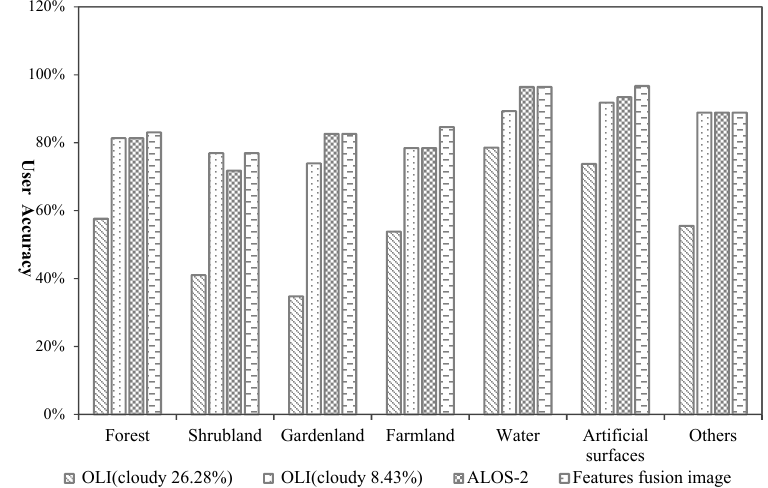
Figure 16. Comparison of user accuracy (UA) of land cover types.